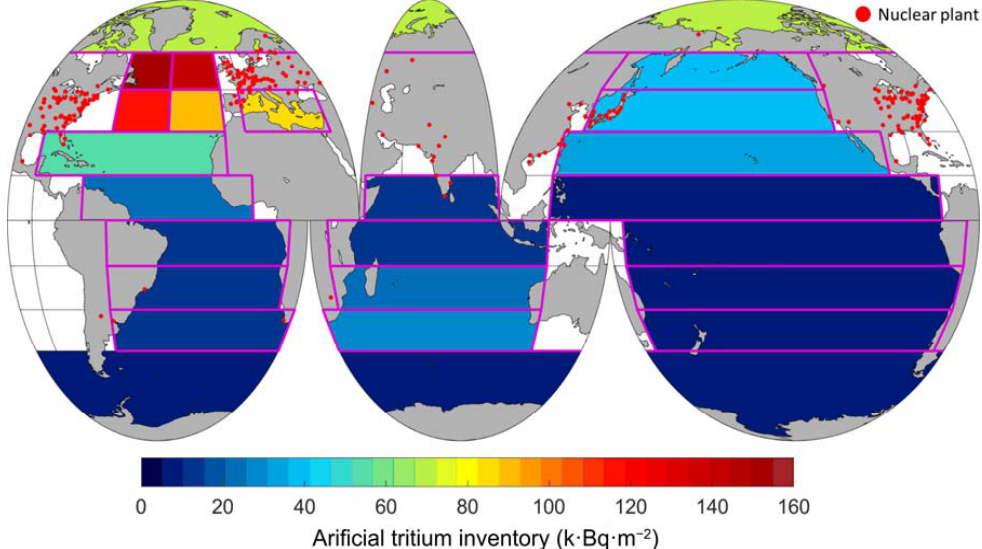
Figure 18. Inventory of anthropogenic tritium by unit of surface area (kBq ∙ m − 2 ), adapted from [65].